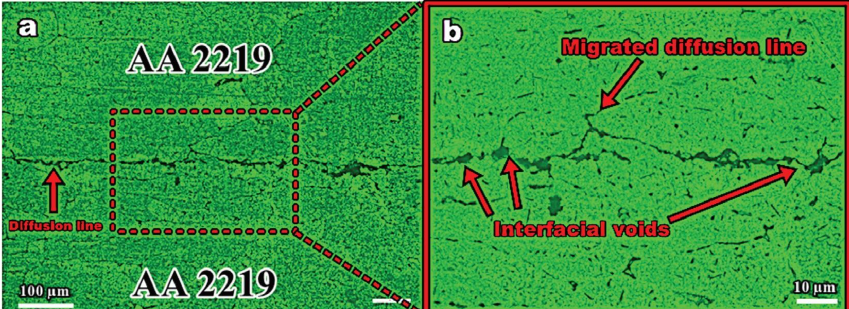
Figure 4: (a) Optical micrographs of the section bonded at 450 ° C and (b) enlarged view of the rectangular drawn in